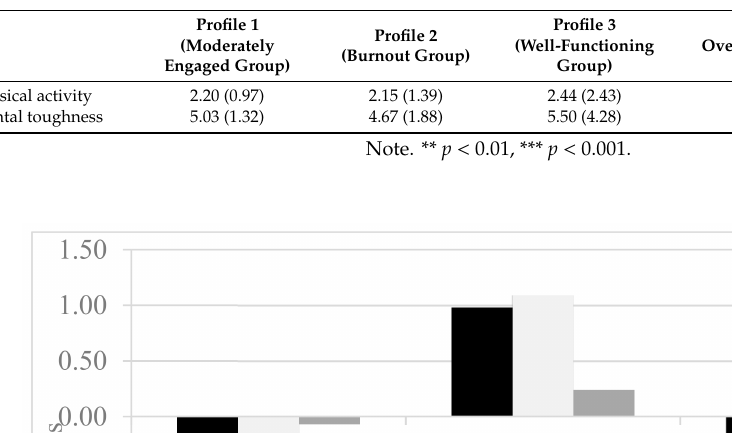
Table 3. Descriptive Scores of physical activity and mental toughness by profile ( n = 1209).